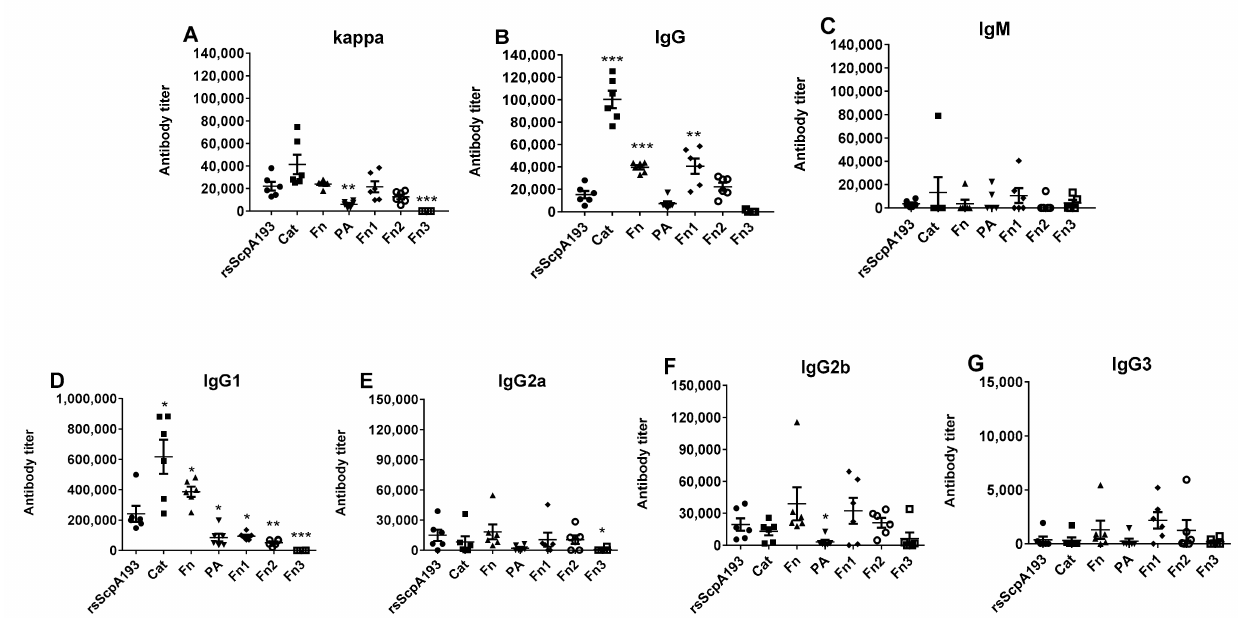
Figure 4. ELISA results of the corresponding protein-specific ( A ) total (anti-kappa), ( B ) total IgG, ( C ) IgM, ( D ) IgG1, ( E ) IgG2a, ( F ) IgG2b, and ( G ) Ig3 antibody titers in the pooled day 35 antisera are displayed. Each dot represents the result of an individual mouse immunized with rsScpA193 ( • ), Cat ( (cid:4) ), Fn ( (cid:78) ), PA ( (cid:72) ), Fn1 ( (cid:7) ), Fn2 ( the black bars show the mean ± SEM values. *: significantly different ( p < 0.05); **: very significantly different ( p < 0.01); ***: extremely significantly different ( p < 0.001) from the data of antiserum